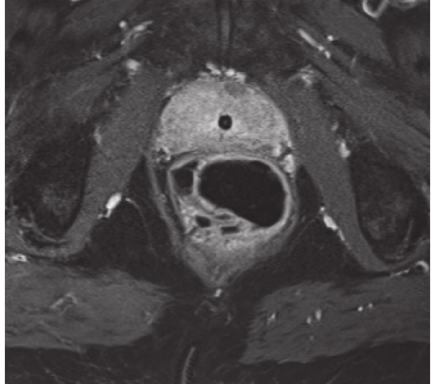
Figure 2: MRI showing anatomical changes of the